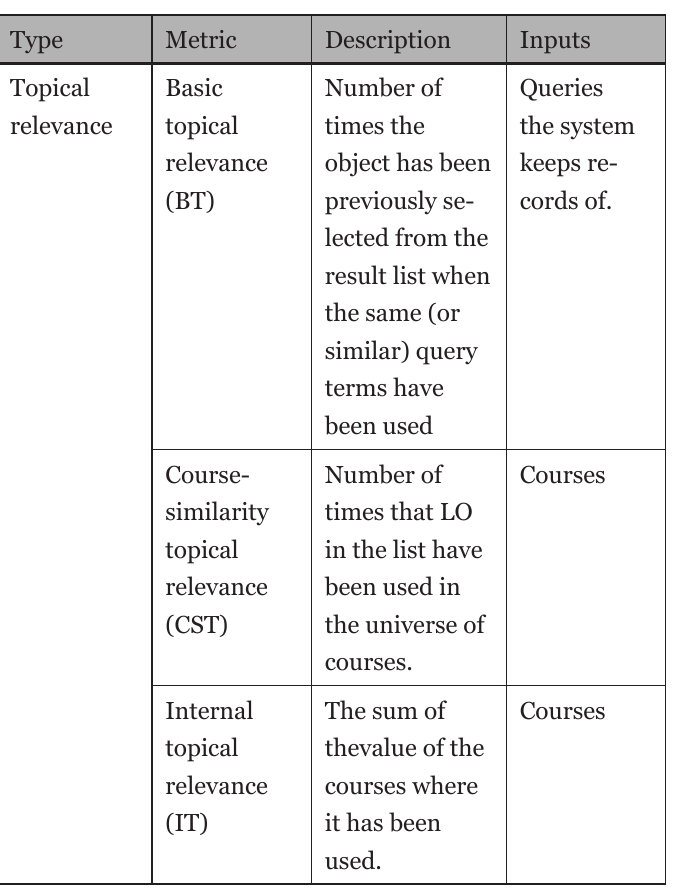
Features of Created